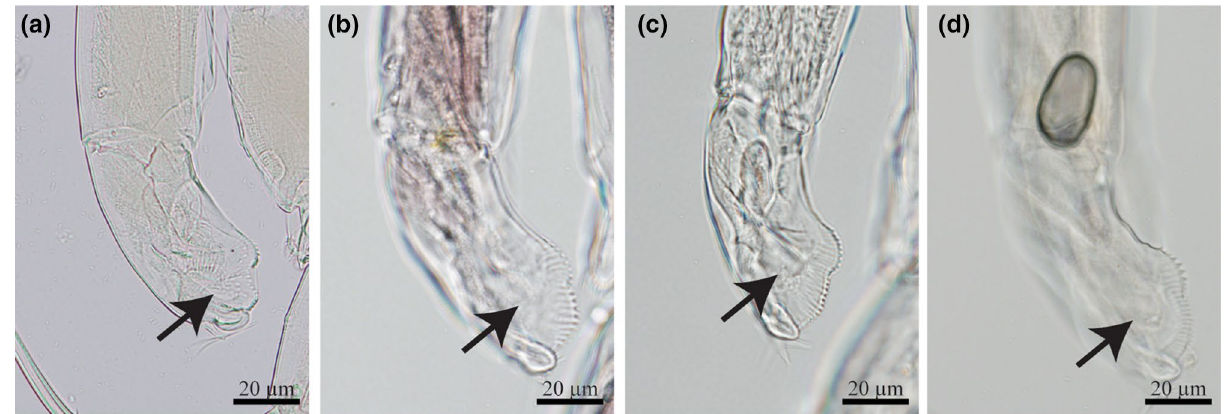
Figure 2. Morphology of the exopod of adult male left P5 in Tropodiaptomus cf. lanaonus . ( a ) specimen from NER. ( b ) specimen from KPK1. ( c ) specimen from NMK4. ( d ) specimen from